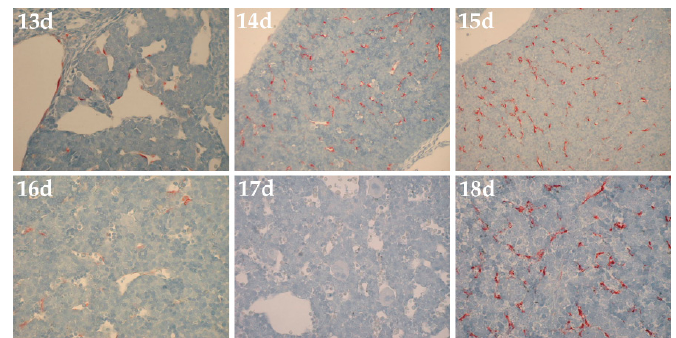
Figure 4. Cycles of HARE expression occur during rat embryonic liver development. HARE/Stab2 protein was detected between day 13 (13d) and day18 (18d) using monoclonal antibodies 30 and 154 raised against purified rat HARE (Magnification 100×). Commercial paraffin tissue blocks (Zyagen) were processed for immunocytochemical staining as described by McGary and co-workers [54,55].